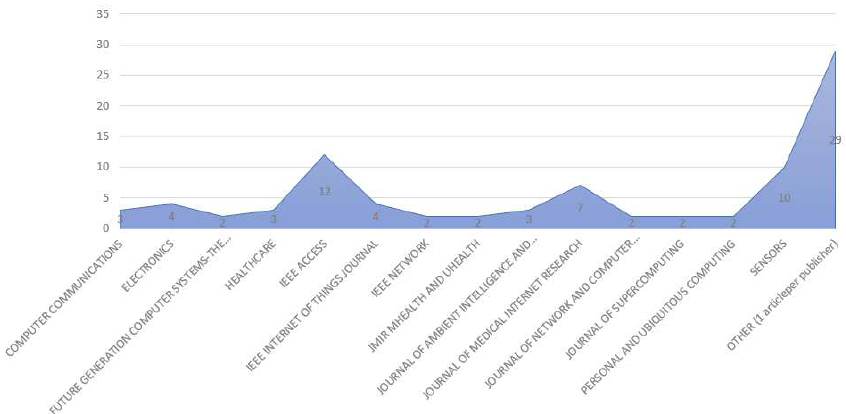
Figure 7. Journal and conference proceedings comparison.